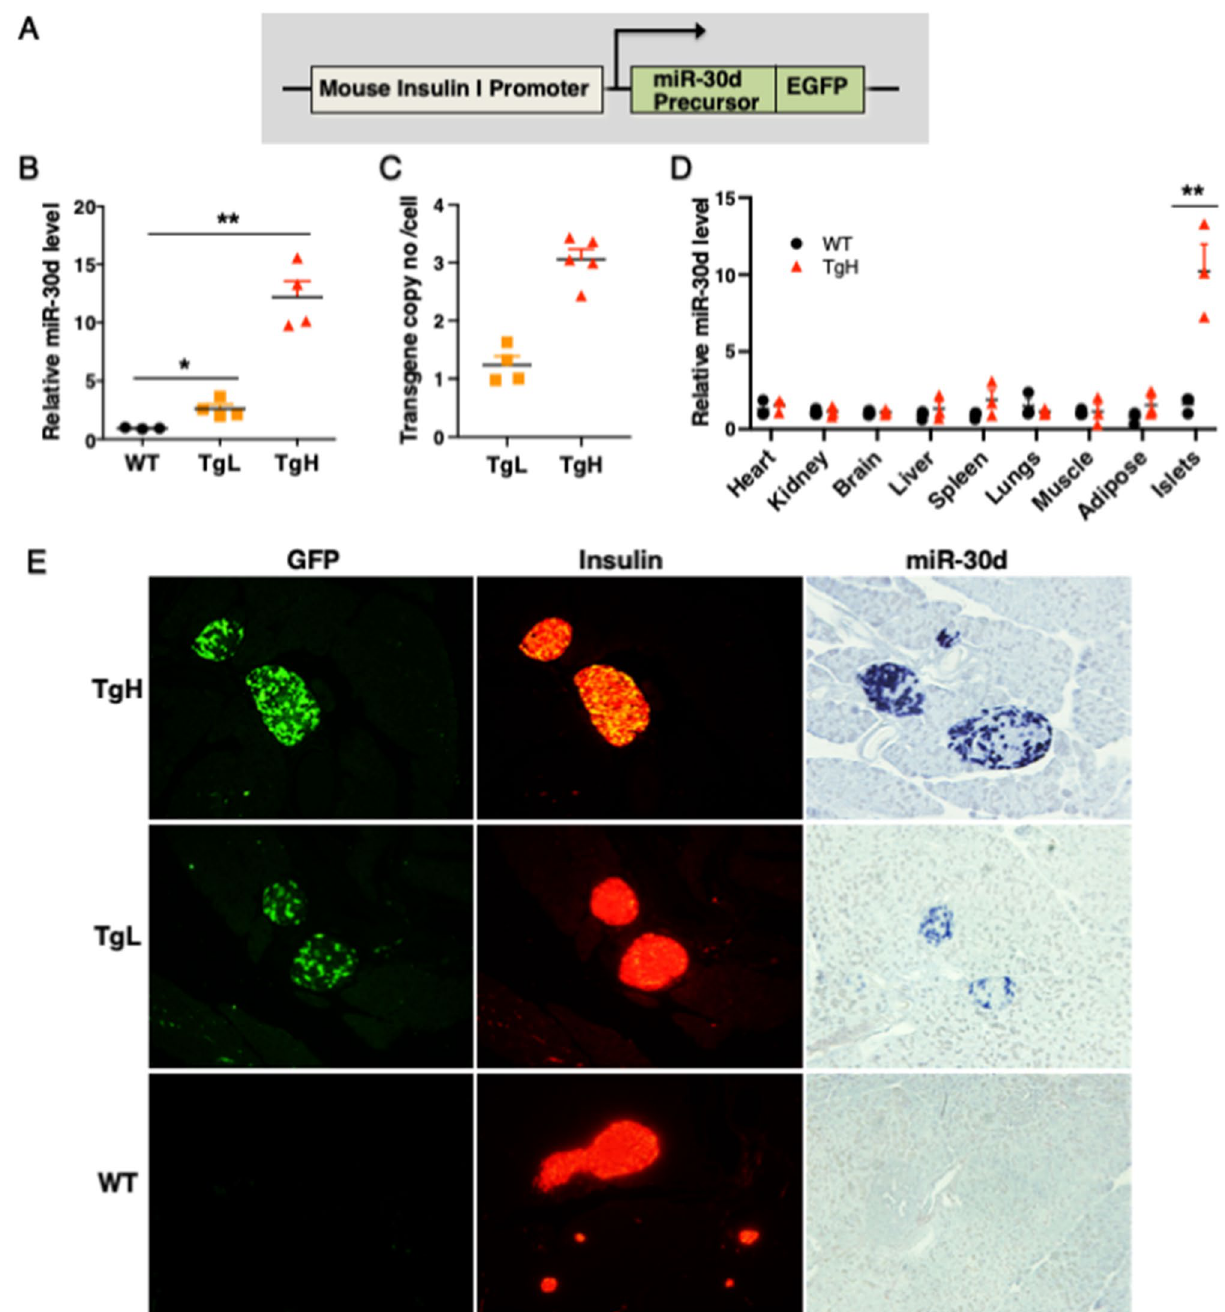
Figure 1. Generation of miR-30d transgenic mice. ( A ) The primary miR-30d fragment was inserted into a β-globin intron associated with an enhanced GFP reporter driven by mouse insulin I gene promoter. The fragment MIP-miR30d-GFP was microinjected into the fertilized eggs of mixed C57BL/6 and SJL mice. ( B ) Two transgenic lines with low and high expression levels of miR-30d (designated TgL and TgH) were selected. RNA was isolated from islets of 10 weeks old male mice (n = 3–4 per group). ( C ) Transgene copy numbers in TgL and TgH lines. The copy number of integrated GFP transgenes was determined on genomic DNA by qPCR using primers for the GFP reporter gene (n = 4–5 per group). ( D ) RT-qPCR confirmed that miR-30d expression was only significantly increased in the islets of transgenic mice. RNA was harvested from islets and various tissues of 14 weeks old male mice (n = 3 per group). ( E ) A representative section of pancreas from 8-week-old mice was visualized by regular immunofluorescence microscopy after staining with anti-GFP (green) and anti-insulin (red) antibodies (20X). In situ hybridization with a DIG-labeled miR-30d probe (blue) confirmed miR-30d is specifically overexpressed in pancreatic β-cells of transgenic mice (20X). All data were presented as mean ± SEM. * p < 0.05, ** p < 0.01 versus